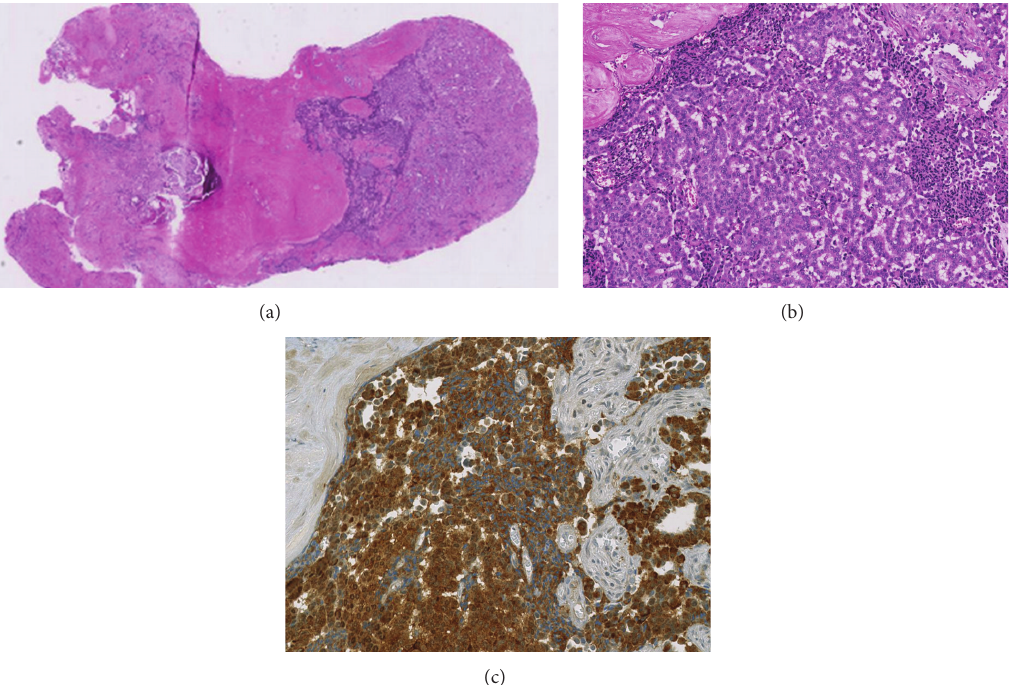
Figure 4: (a) Histological finding (overview), neuroendocrine adenoma (hematoxylin-eosin stain). (b) Histological finding (magnification), neuroendocrineadenoma(hematoxylin-eosinstain).(c)Histologicalfinding(magnification),neuroendocrinedifferentiation(synaptophysin